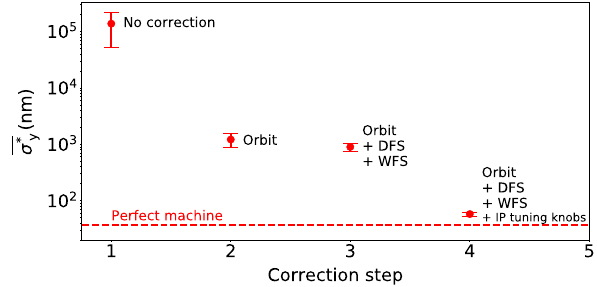
FIG. 9. Effect of both incoming 0.1, 0.3, 0.5 and 1 . 0 σ y beam position and 0.1, 0.3, 0.5 and 1 . 0 σ y 0 beam angle jitters on the average vertical IP beam size ( σ (cid:1) y ) vs the beam intensity, calculated with PLACET incorporating wakefields. The error bars represent the standard error for 100 machines and 200 pulses per machine. The dashed lines (w) show fits of Eq. (1).